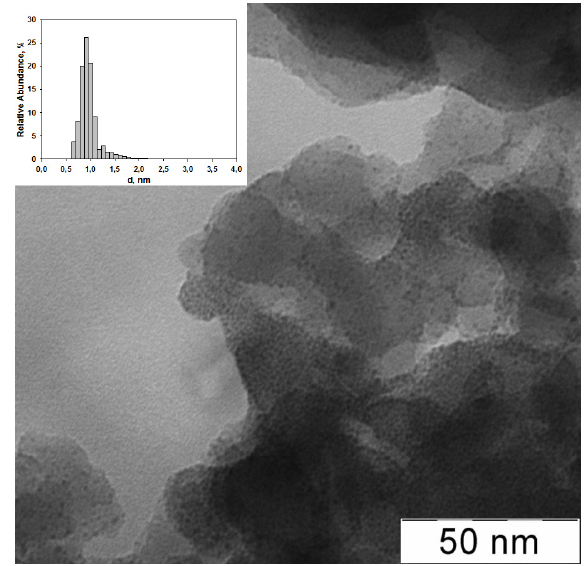
Figure 4. G3-dendr-SiO 2 -Ru catalyst: TEM microphotography and particles size distribution.